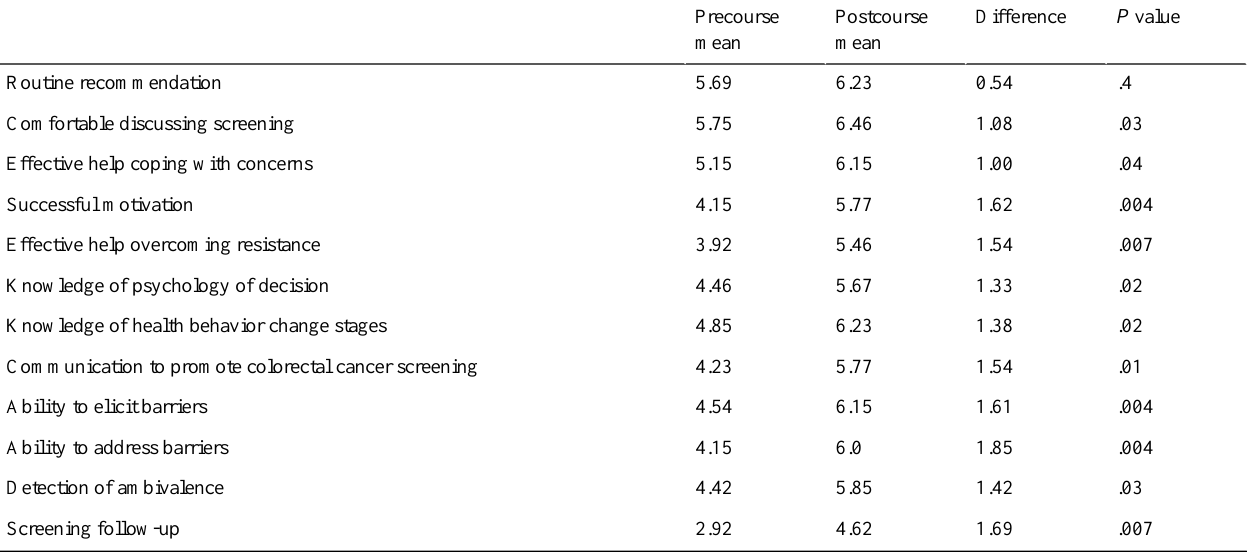
Table 1. Participants’ self-reported mean change in knowledge and confidence scores in colorectal cancer screening counseling practices (N = 13 for each